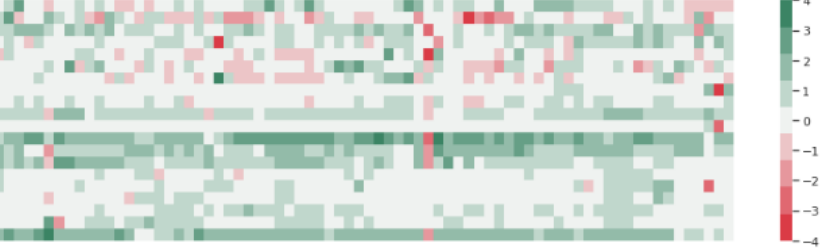
Figure 7. Color map of change. Red indicates a negative change; green indicates a positive change; white indicates no change. Each row is a questionnaire answered by a parent; each column is a